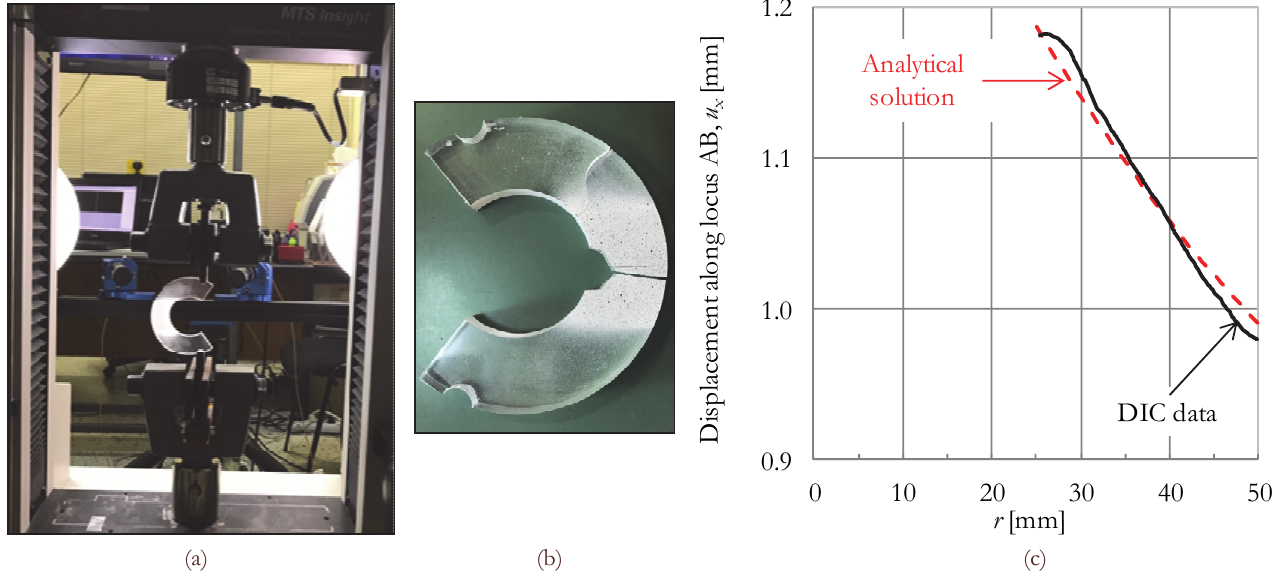
Figure 4: (a) An overview of the experimental set-up; (b) A fractured CSR specimen; (c) Analytic versus experimental data for the dis- placement component developed along the critical locus